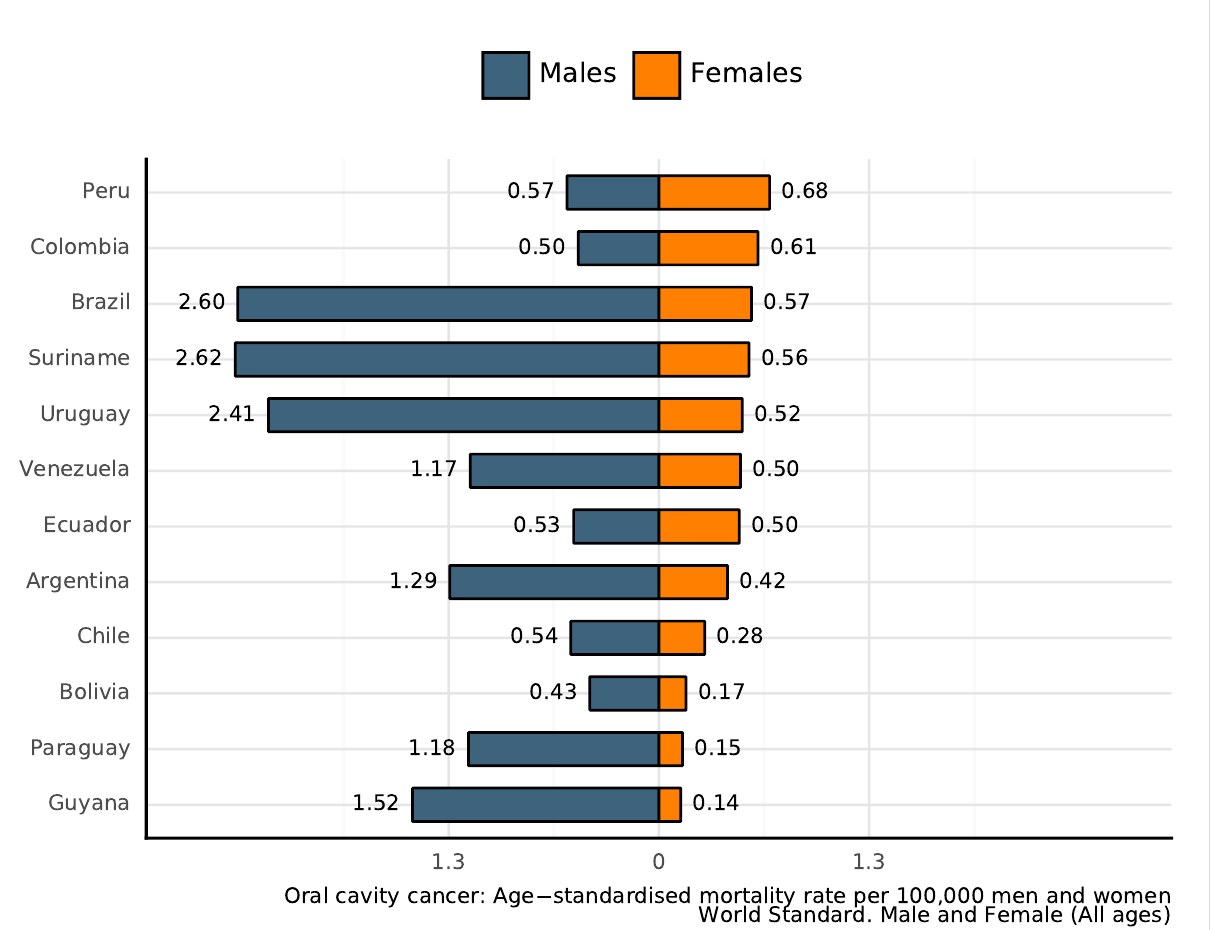
Oral cavity cancer: Age standardised mortality rate per 100,000 men and women World Standard. Male and Female (All